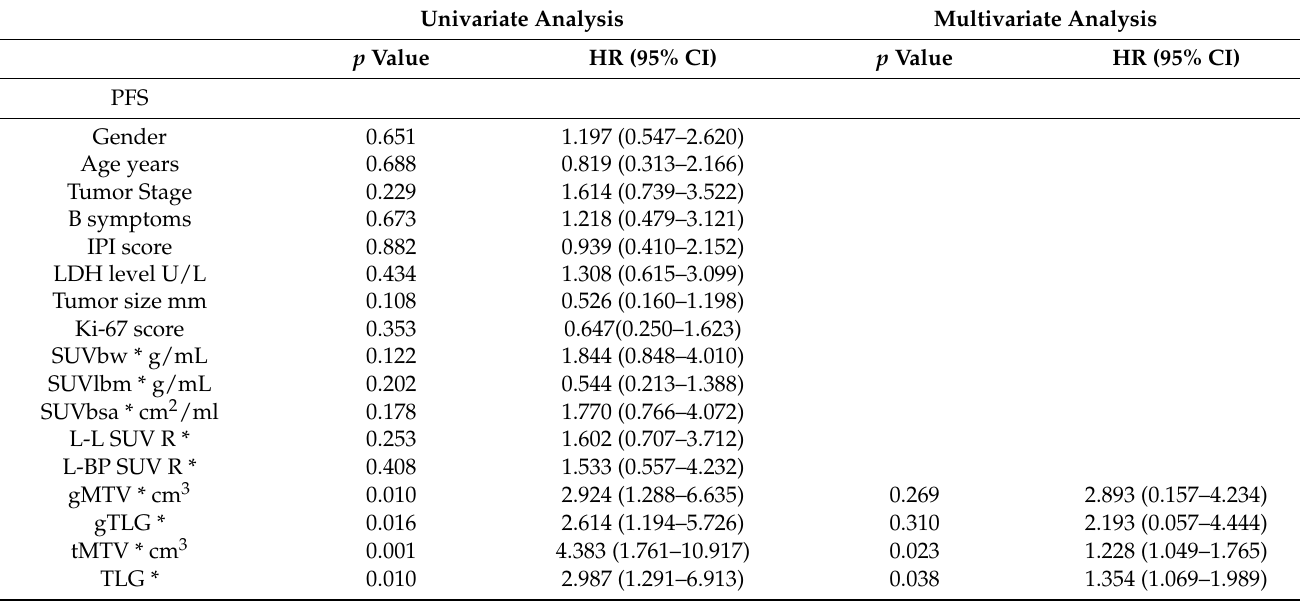
Figure 3. OS curves according to pretreatment gMTV ( a ), gTLG ( b ), tMTV ( c ), and TLG ( d ) threshold. Table 4. Univariate and multivariate analyses for PFS and